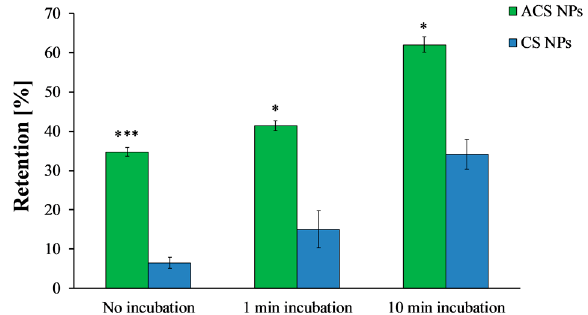
Figure 6. Final retention percentages of ACS nanoparticles (green) and CS nanoparticles (blue) obtained after different incubation time intervals (ANOVA, p < 0.0001, n = 3, p < 0.05, n = 3, respectively). (*) refers to statistically significant difference ( p < 0.05), and (***) refers to statistically significant difference ( p < 0.001).